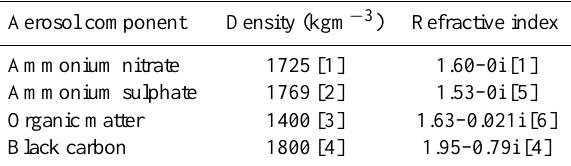
Table 3. Summary of the individual component densities and re- fractive indices used in this study. The numbers in brackets refer to the study referenced for the associated parameter value, which are as follows: [1] Weast (1985), [2] Penner et al. (1998), [3] Alfarra et al. (2006), [4] Bond and Bergstrom (2006), [5] Toon et al. (1976) and [6] Dinar et al.